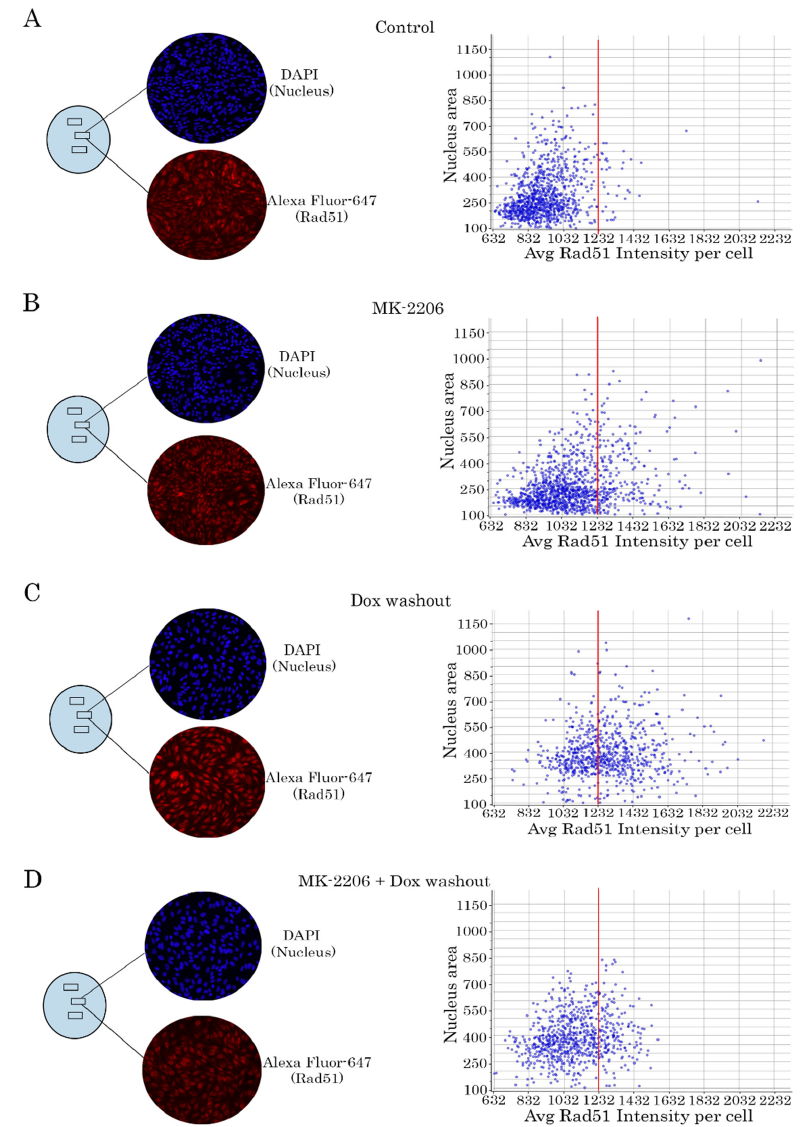
Figure 6. Inhibition of AKT-signaling attenuates Rad51 expression in Dox-treated cells (representative experiment). ( A – D ) GIST T-1R cells were treated similarly as shown for Figure 4. Left panel—cells were fixed with paraformaldehyde and stained with DAPI (blue) to outline the nucleus and Rad51-specific antibody (red). The intensity of Rad51-specific fluorescence was assayed for each nucleus (DAPI) and quantified automatically. Right panel—histograms illustrating the intensity of Rad51-specific fluorescence at the single-nucleus level. All images were acquired by GE Cytell imager as shown in “Materials and methods”.